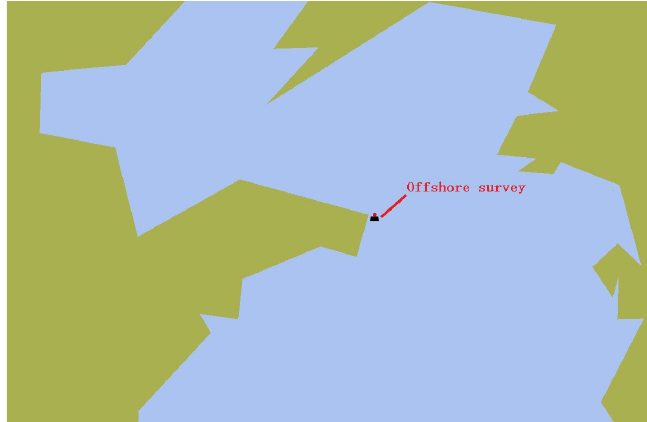
Figure 17. Offshore survey location.